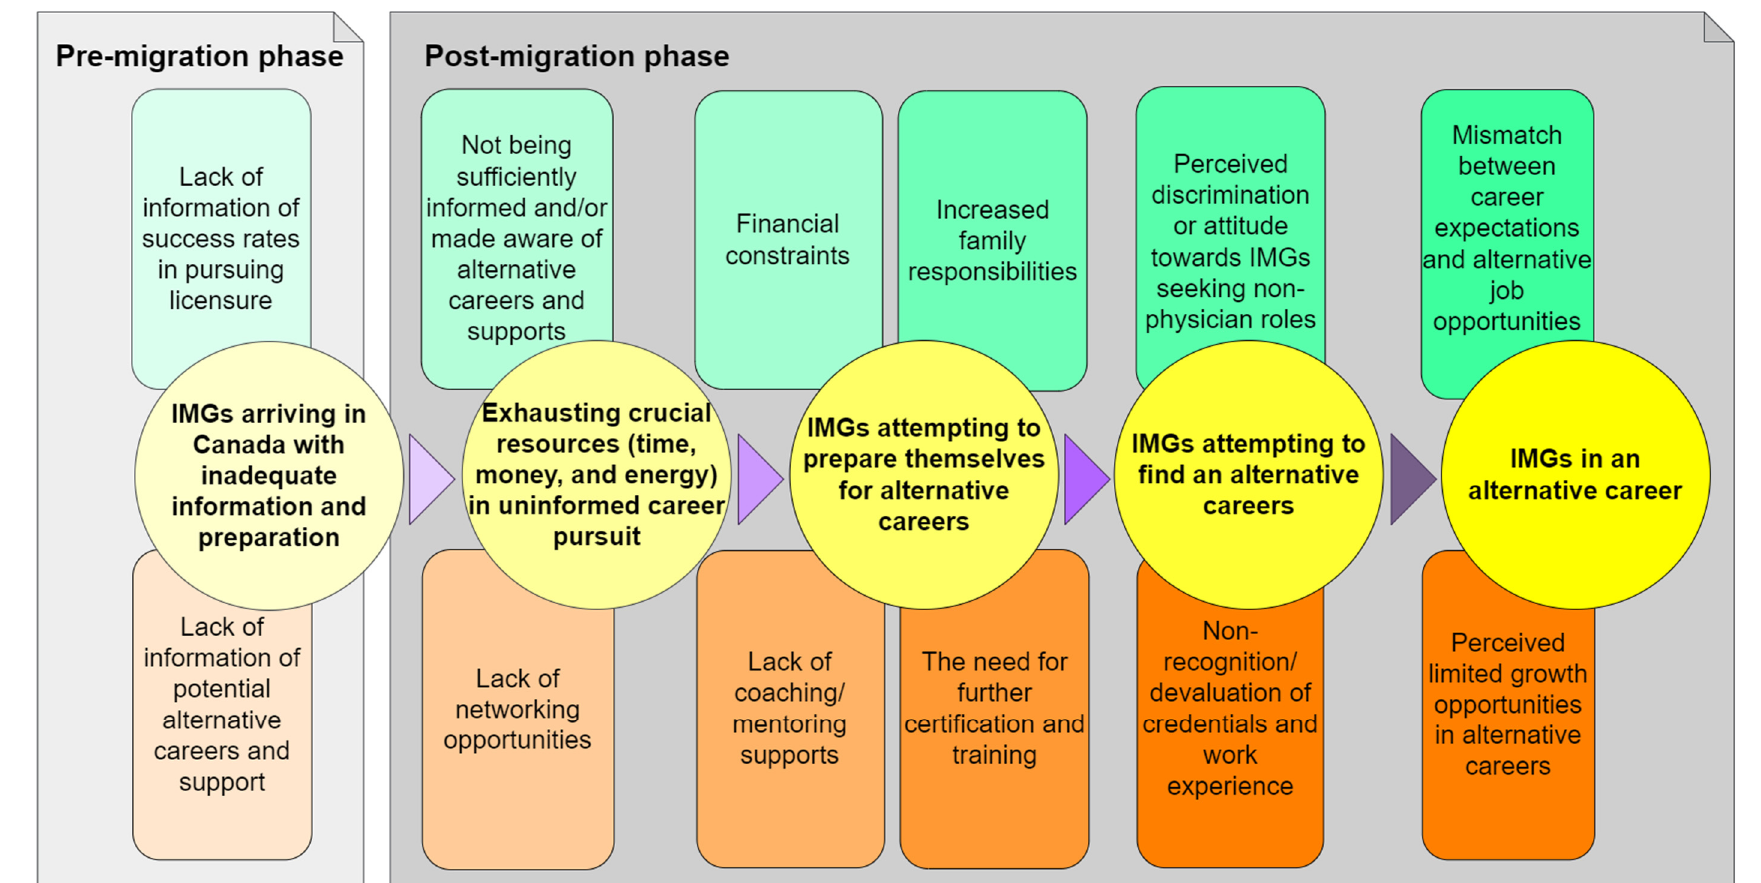
Figure 1. Distribution of barriers to alternative career pursuit for IMGs across their resettlement journey in Canada.